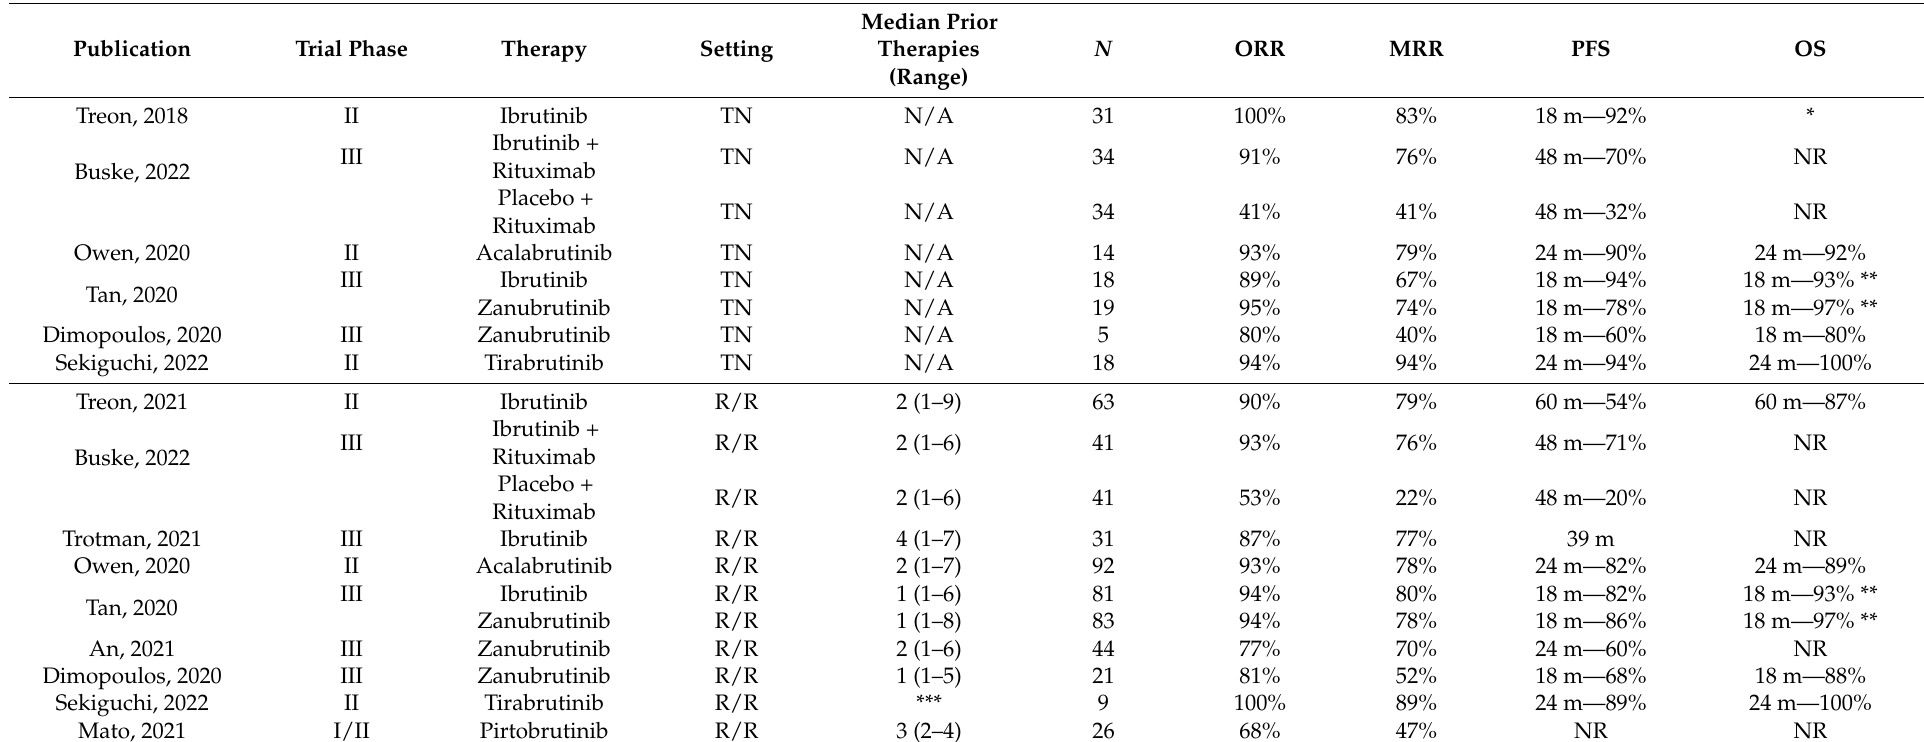
Table 1. Efficacy outcomes in large BTKi trials in TN and R/R